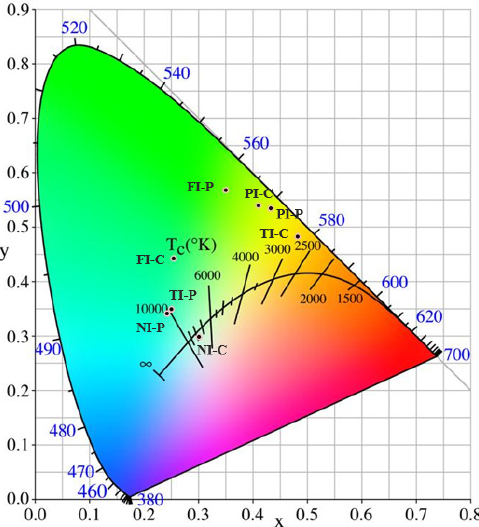
Figure 4. Commission Internationale de l’Eclairage (CIE) chromaticity coordinates for precipitation and crystallization samples of PI , NI , TI and FI.